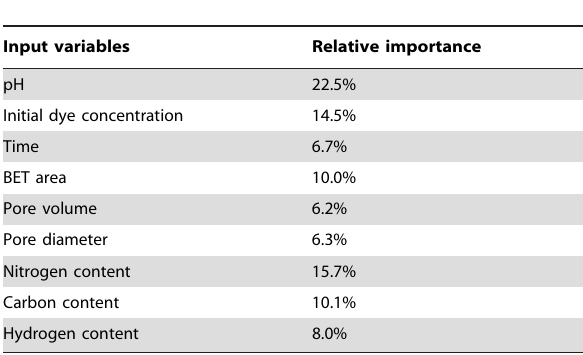
Table 6. The relative importance of input variables by